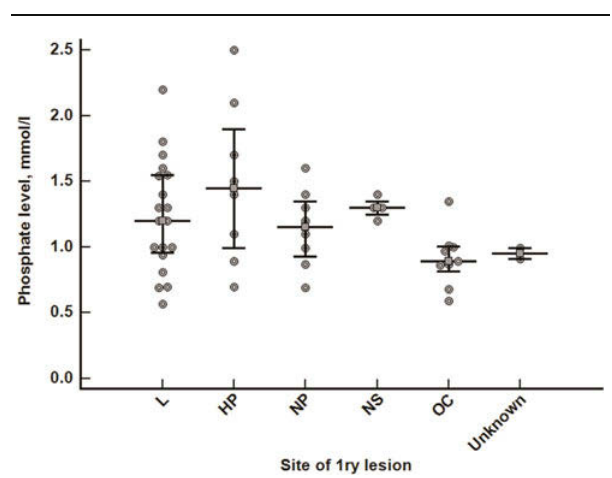
Phosphate level by site of HNC. Circular markers represent individual observations. Squared marker with traversing horizontal line repre- sents the median (second quartile). Error bars represent the 25th and 75th percentiles (first and third quartiles, respectively). HNC, head and neck cancer; HP, hypopharyngeal; L, laryngeal; NP, nasopha- ryngeal; NS, nasal sinus; OC, oral cavity.